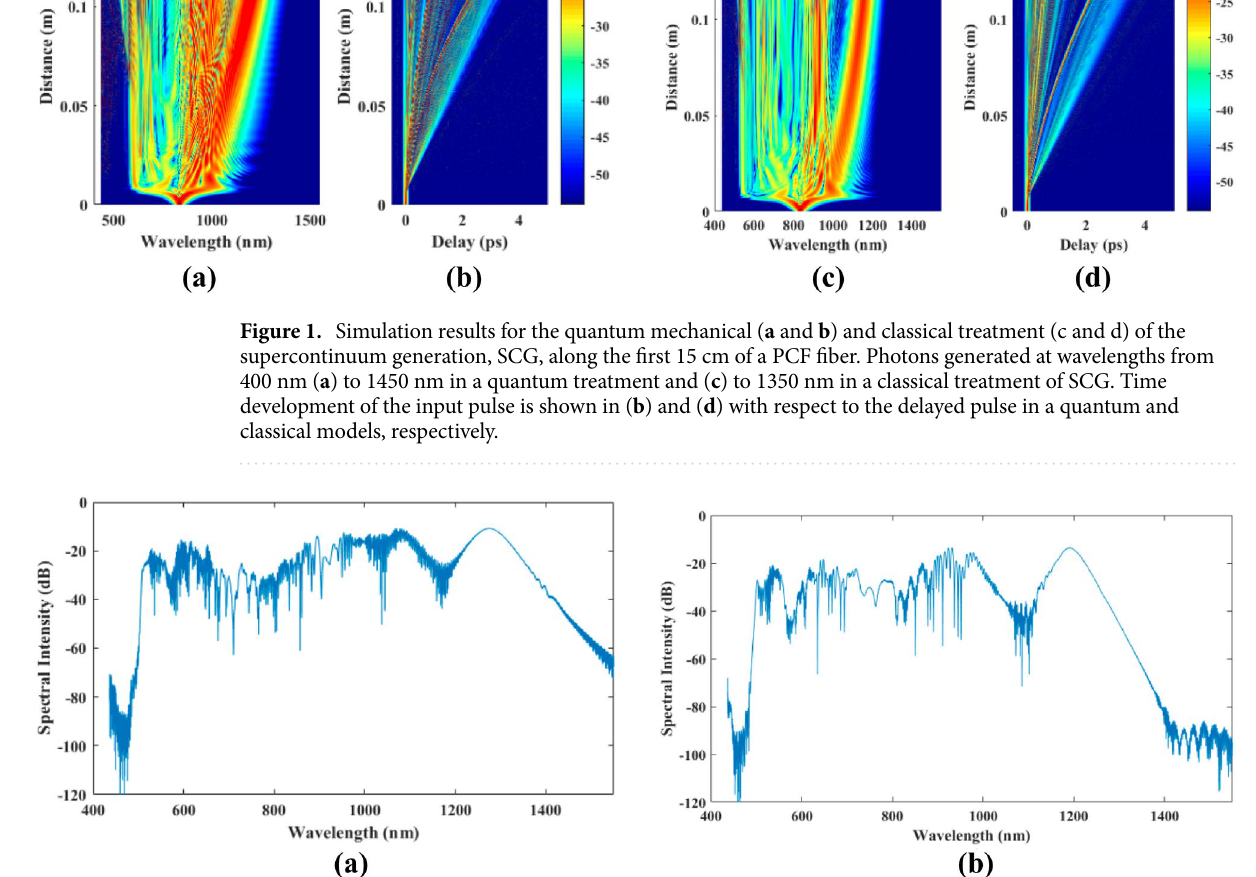
Figure 2. The generated wavelengths at the output of a 15 cm PCF in ( a ) quantum mechanical and ( b ) classical calculations for the input pulse of 10 kW power and 28.4 fs pulse width at 835